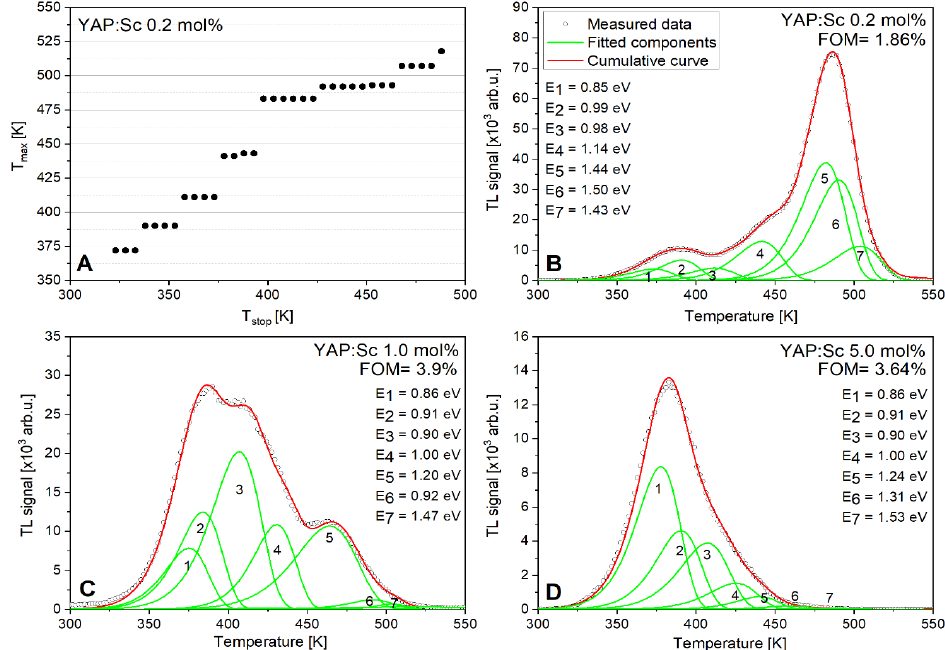
Figure 8. ( A ) An exemplary result of the T stop –T max procedure applied for the studied samples. ( B, C , D ) The results of deconvolution performed for Sc 3+ -doped YAlO 3 crystals with different dopant concentrations.